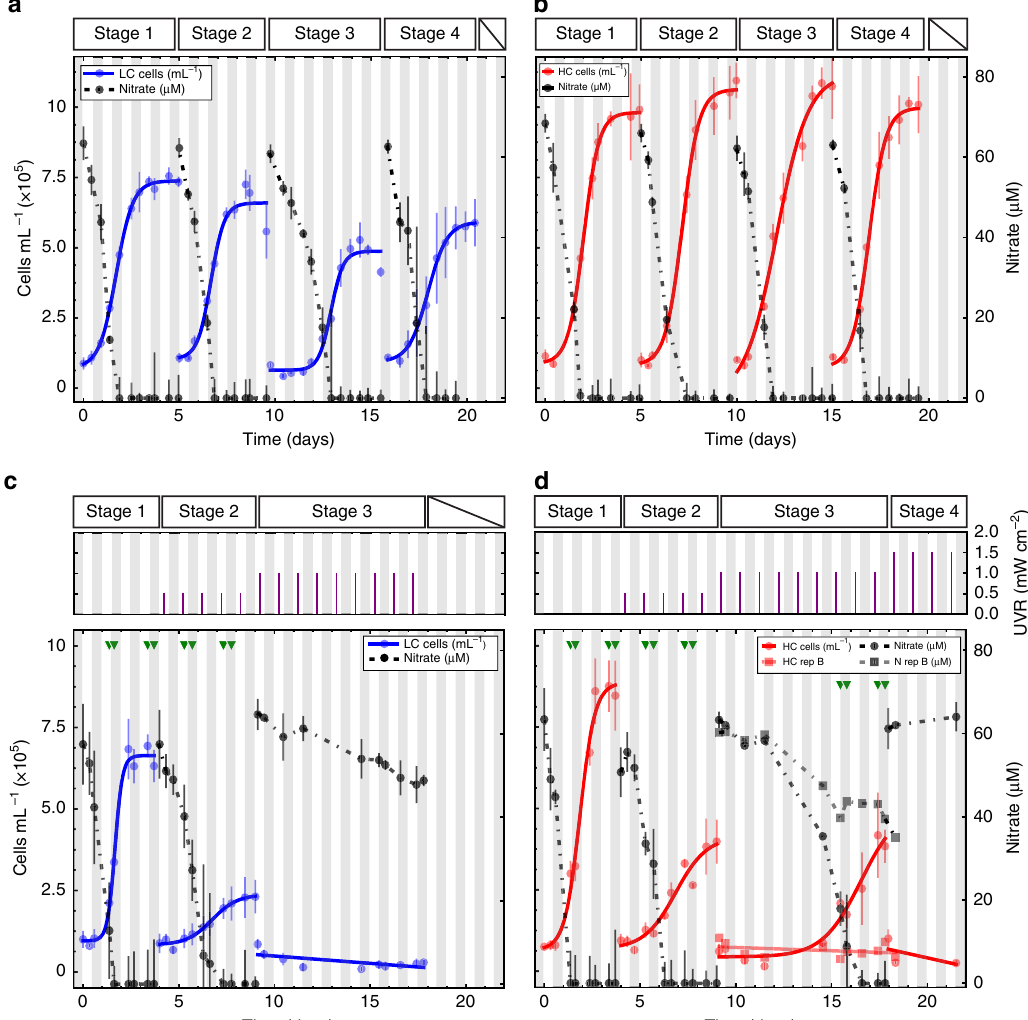
Fig. 1 Growth dynamics of T. pseudonana at LC and HC conditions during non-UVR growth transitions and the stress test. Growth characteristics of T . pseudonana cultures without UVR under LC (300 ppm CO 2 ; a ) and HC conditions (1000 ppm CO 2 ; b ). Number of cultures across all non-UVR stages ( = 3; n = 3). During the stress test cultures at LC ( c ) and HC ( d ) conditions received progressively higher doses of UVR in each stage HC stage 1,2,3,4 stage 1,2,3,4 ( n LC stage 1,2,3 = 3; n HC stage 1,2, = 3; n HC stage 3,4, = 2); see Methods for detailed experimental design. Dashed black lines represent the decrease in nitrate levels to below detection (<1 μ M). Vertical error bars denote the standard deviation of the mean. White and gray bars in the background indicate the 12 h light and 12 h dark phases of the diurnal cycle, respectively. Purple lines indicate UVR dose in mWcm − 2 . Green triangles mark time-points at